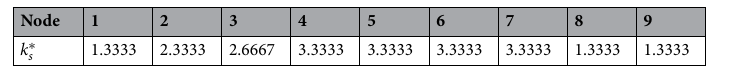
Table 3. The k ∗ s value of each node in the toy network.